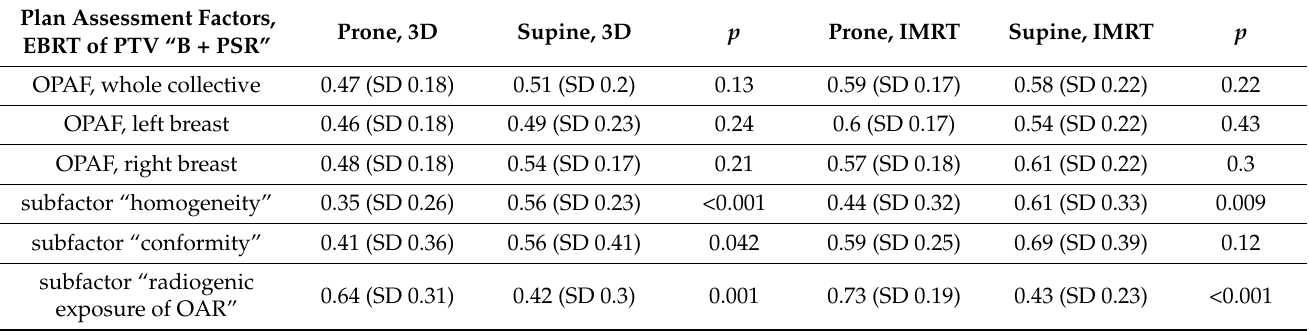
Table 4. Plan assessment factors for EBRT of PTV “B-PSR”. Listed are the overall plan assessment factors by the collective (left and right) as well as the individual subfactors, homogeneity, conformity, and radiogenic exposure of OAR, in each case for positioning in the prone and the supine positions as well as the 3D- and IMRT-planning techniques. Each result reaches a value between 0 and 1 (whereby plan quality increases with the value). OPAF: overall plan assessment factor; OAR: organs at risk; SD: standard